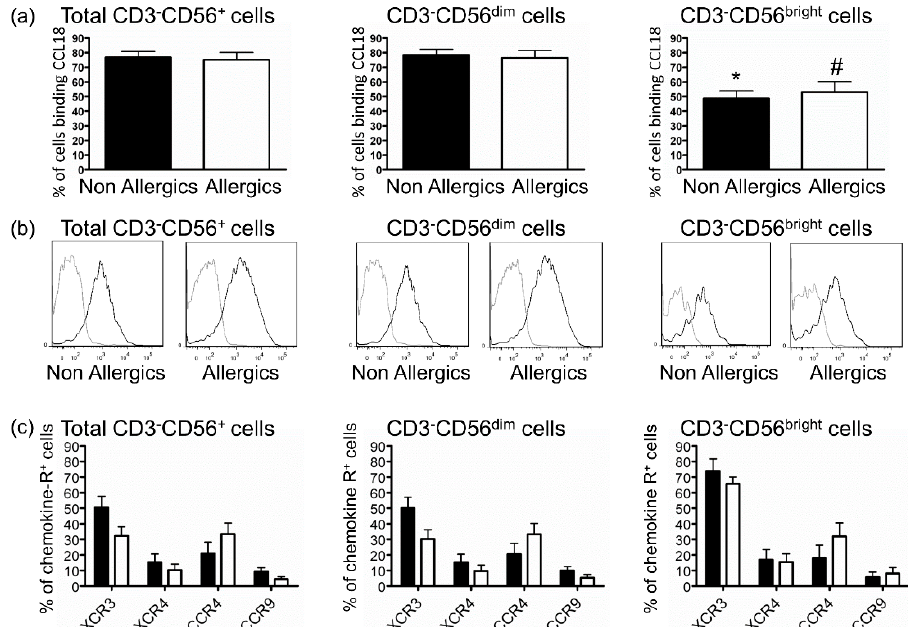
Figure 5. CCL18 binds to NK cells from both allergic and nonallergic donors. ( a ) Mean ± standard error of the mean (SEM) of percentages of cells binding CCL18 among total CD3 − CD56 + , CD3 − CD56 dim , CD3 − CD56 bright NK cells for nonallergic ( n = 7) and allergic ( n = 6) donors. Results are expressed as mean percentage of CCL18 bound positive cells (% of cells binding CCL18) cells ± SEM. * and #: p < 0.05 between CD3 − CD56 dim and CD3 − CD56 bright NK cells for nonallergic and allergic donors, respectively. ( b ) A representative histogram of CCL18 binding for each subset is shown for one nonallergic and one allergic donor. Black histogram: biotinylated-CCL18, grey histogram: nonrelevant biotinylated protein. ( c ) Expression of other chemokine receptors on total or subsets of NK cells, isolated from nonallergic (black columns, n = 8) or allergic (white columns, n = 12) donors. Results are expressed as mean percentage of chemokine receptor positive (% chemokine-R + ) cells ± SEM.